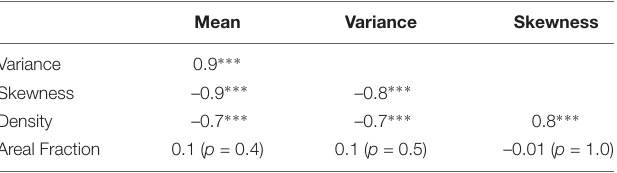
TABLE 2 | Correlation matrix of distribution